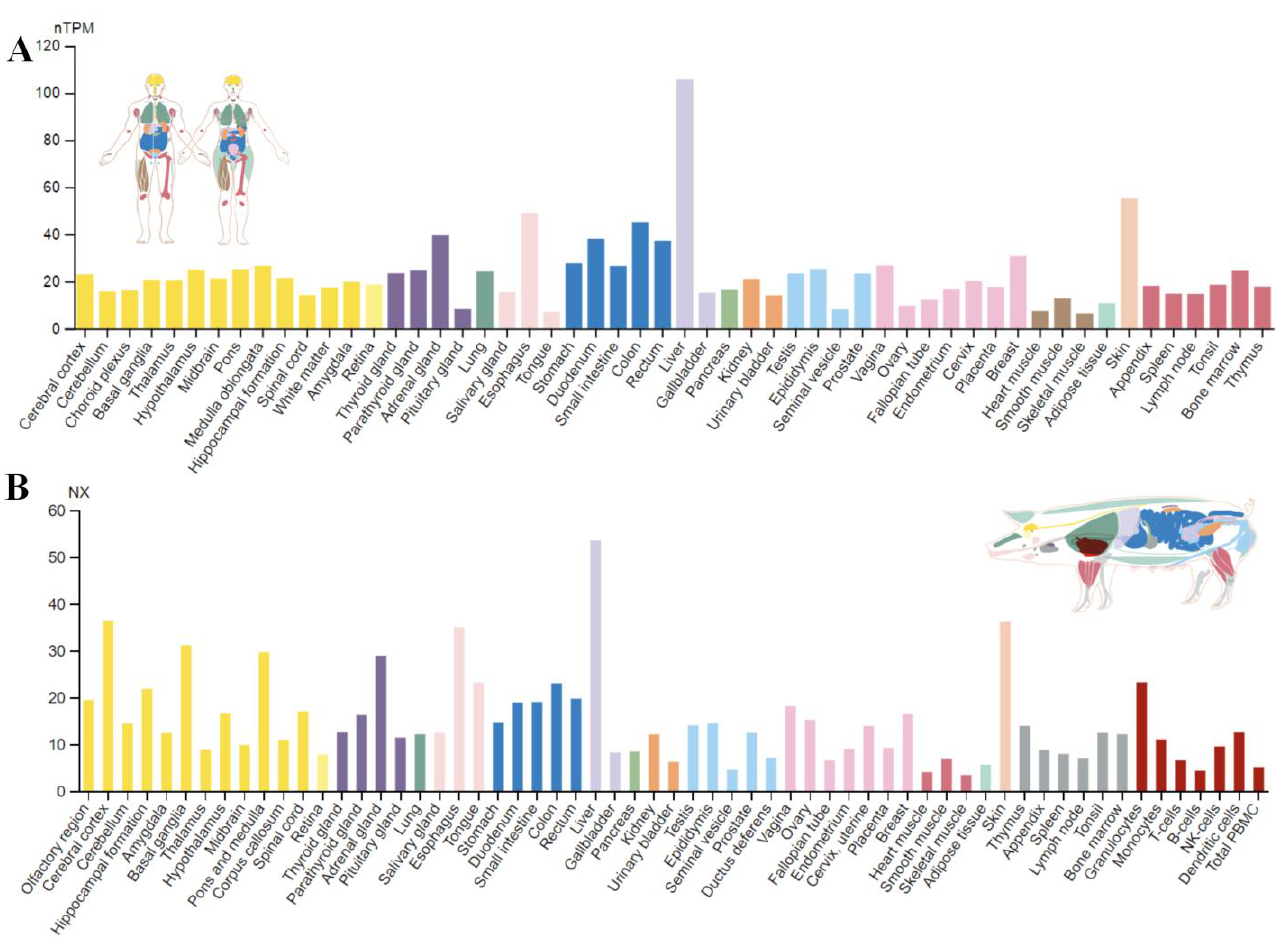
Figure 1. HMGCR expression profile in human ( A ) and pig ( B ) tissues. Data credit: The Human Protein Atlas [60,61] and The Pig RNA Atlas [61,62]. Data summary images were obtained from v22.proteinatlas.org via https://www.proteinatlas.org/ENSG00000113161-HMGCR/tissue (human protein expression profile, accessed on 10 January 2023) and https://www.rnaatlas.org/ENSSSCG0 0000014080-HMGCR (pig protein expression profile, accessed on 10 January